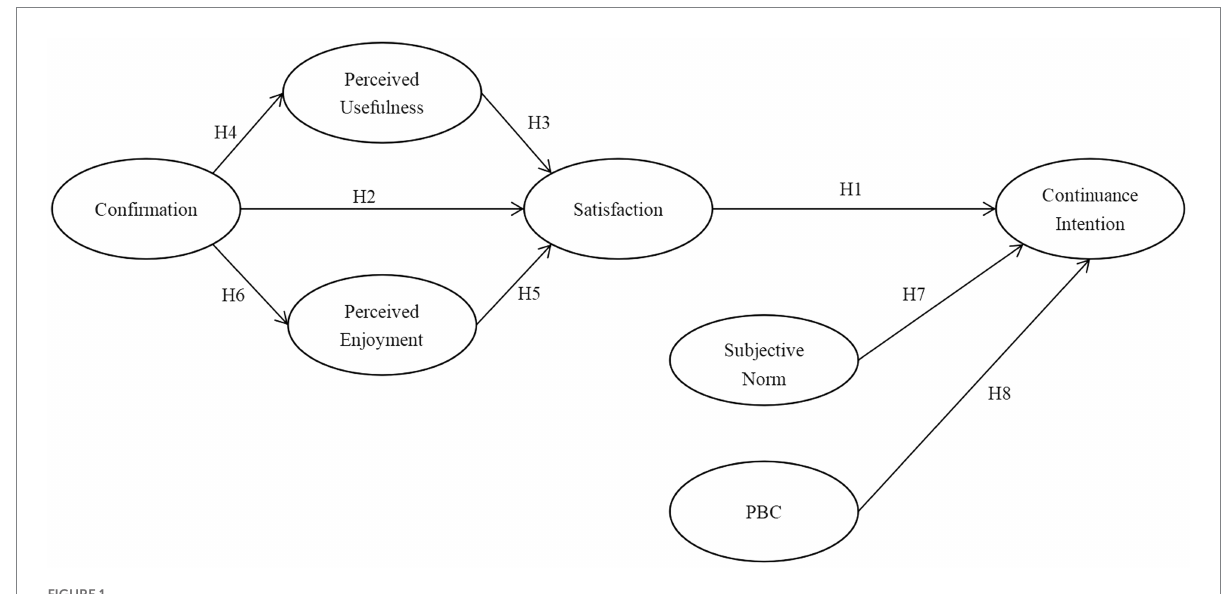
FIGURE 1 Research model proposed in the